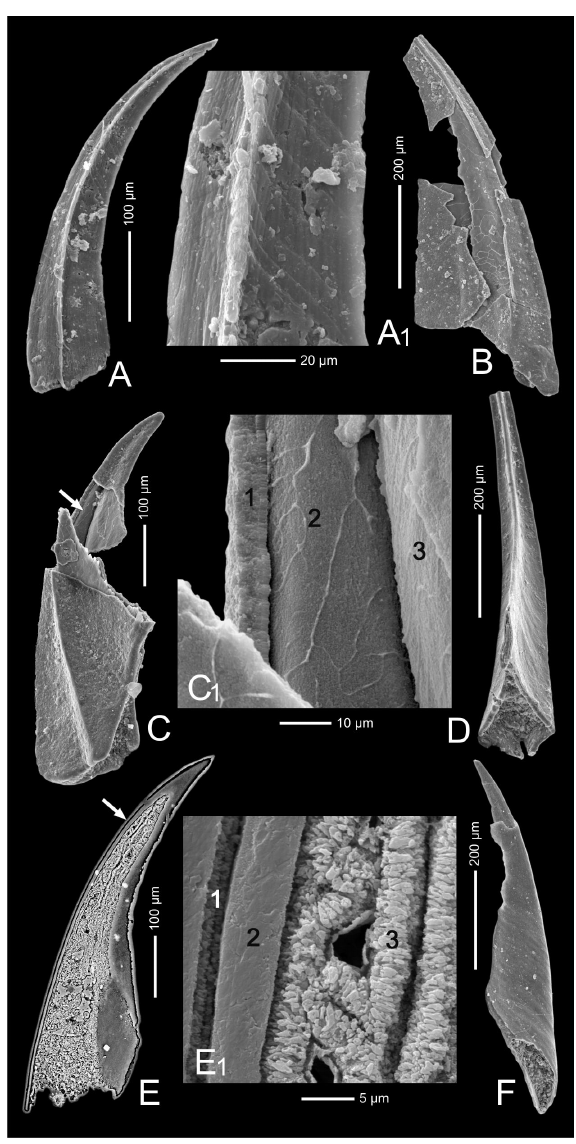
Fig. 2. A (cid:150) F , inner structure of the elements of coelocerodonts; Tremadocian, Sweden, ˜leklinta; ZPAL C23/17(cid:150)23: A , specimen without the outer layer, A 1 , higher magnification of the middle part showing diagonal striations; B , specimen partly crushed to show that the outer layer of some specimens can be easily separated; C , specimen specially fractured to show its inner structure, the arrow points to the magnified fragment; C 1 , higher magnification; 1, fracture of the outer layer; 2, surface of the inner layer; 3, inner surface of the outer layer. D , F , specimens showing diagonal striations. E , specimen longitudinally sectioned and etched, the arrow points to the magnified fragment; E 1 , higher magnification; 1, the outer layer; 2, the inner layer; 3, secondary filling of the specimen